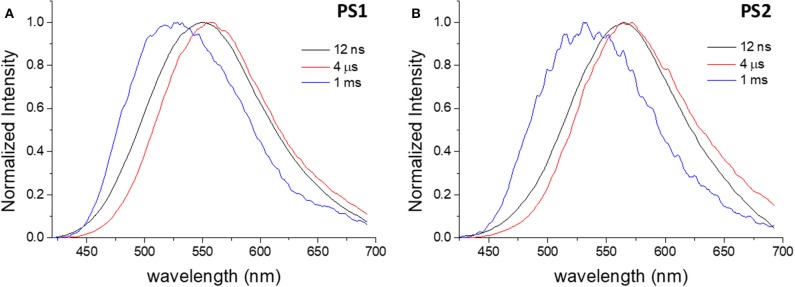
Normalized time-resolved emission spectra of PS1 (A) and PS2 (B) in degassed aqueous suspension, collected at different delay times. λex = 355 nm.